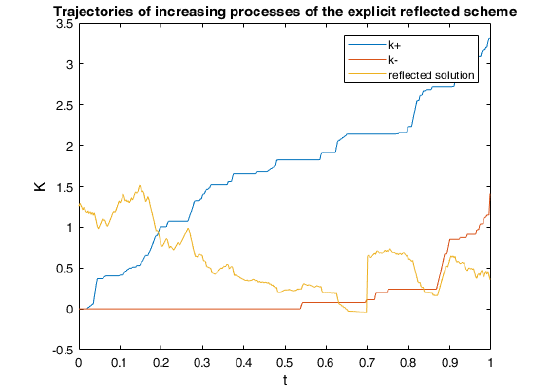
Figure 5. The paths of the increasing processes in the explicit reflected scheme ( τ = 0.7).